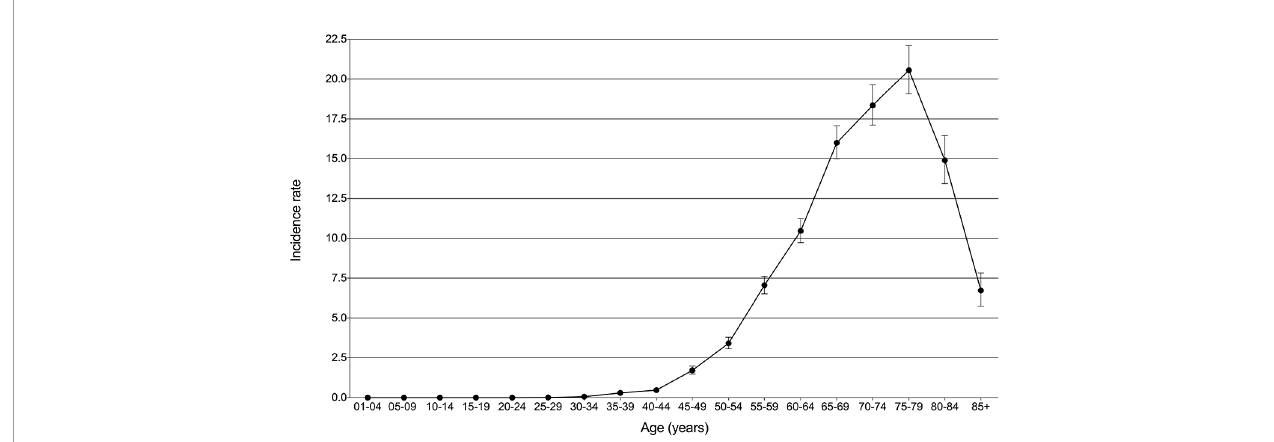
FIGURE 2 | Incidence rates (per million) with 95% CI over age for pulmonary large cell neuroendocrine carcinoma.